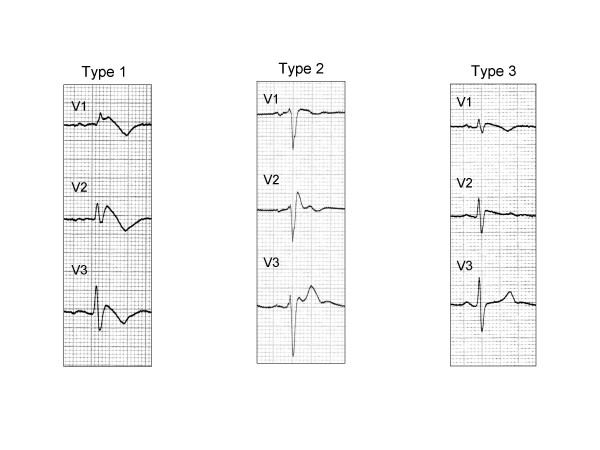
ECG pattern in Brugada syndrome. According to recent consensus document (ref 13), type 1 ST segment elevation either spontaneously present or induced with Ajmaline/Flecainide test is considered diagnostic. Type 1 and 2 may lead to suspicion but drug challenge is required for diagnosis. The ECGs in the right and left panels are from the same patient before (right panel, type 1) and after (left panel, type 1) endovenous administration of 1 mg/kg of Ajmaline during 10 minutes.